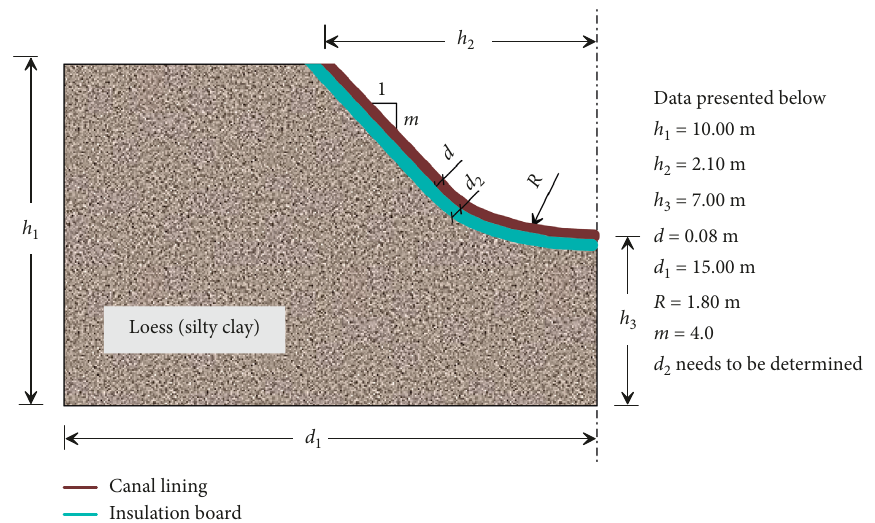
Figure 12: Geometric model for numerical computation.